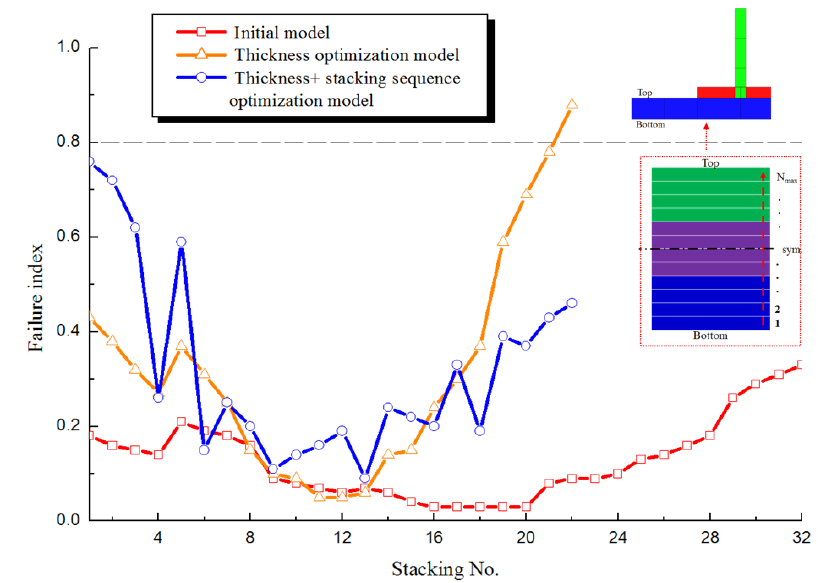
Figure 13. F ailure index results according to laminate sequence.